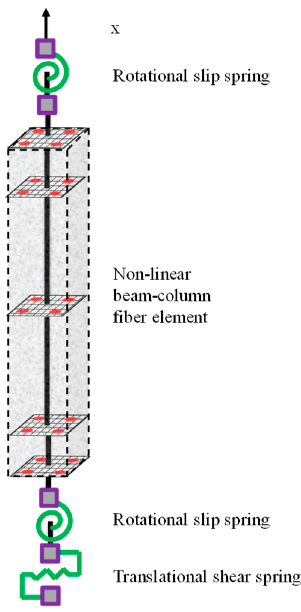
Figure 2. Numerical finite element model adopted in this study (x is the element local axis).